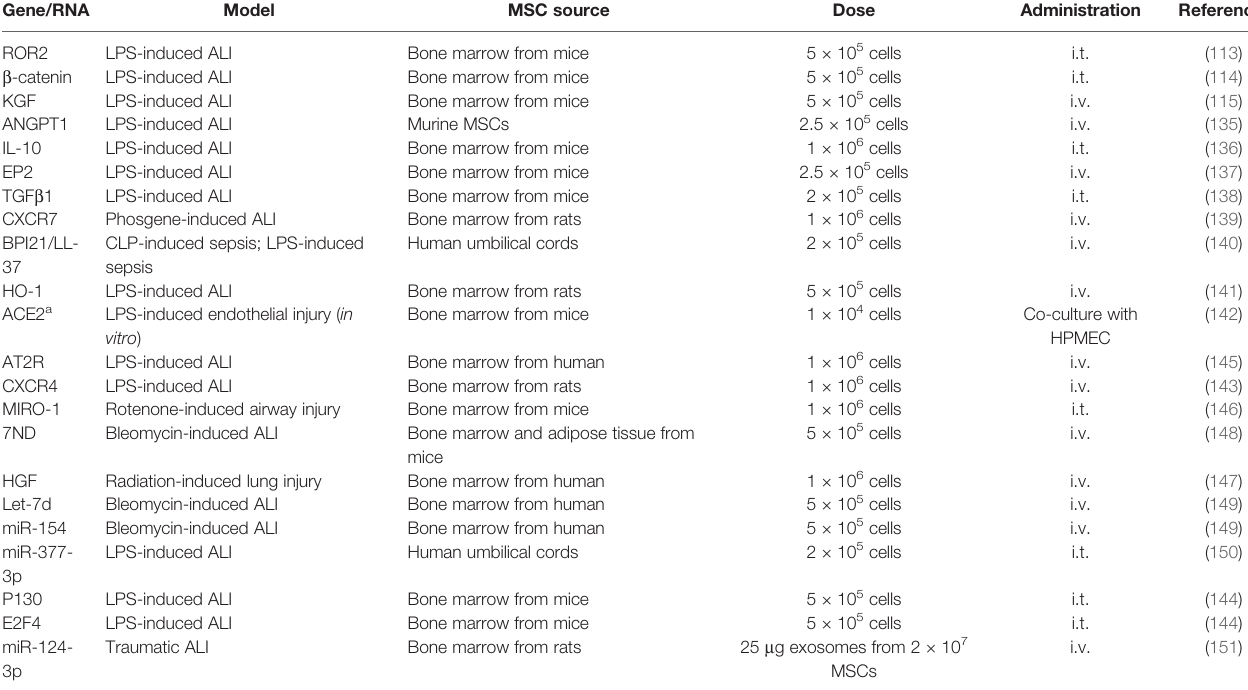
TABLE 2 | Genetically modi fi ed MSCs in treatment-based studies using models of ALI and sepsis.